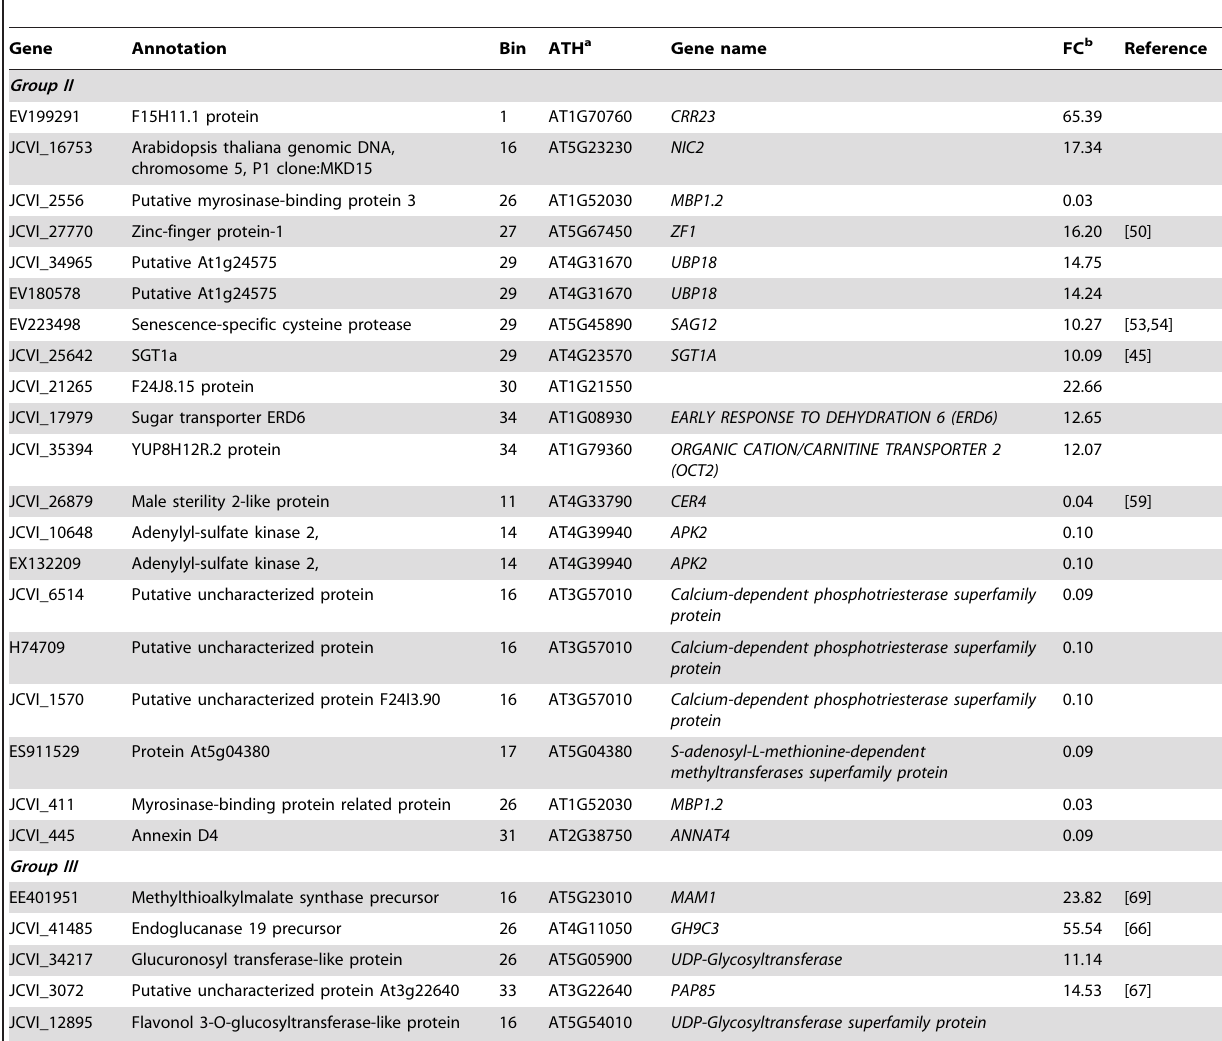
Table 2. List of genes ( Hsf and Hsp genes excluded) exhibiting more than 10-fold changes in expression only in the SW (group II) or seeds (group